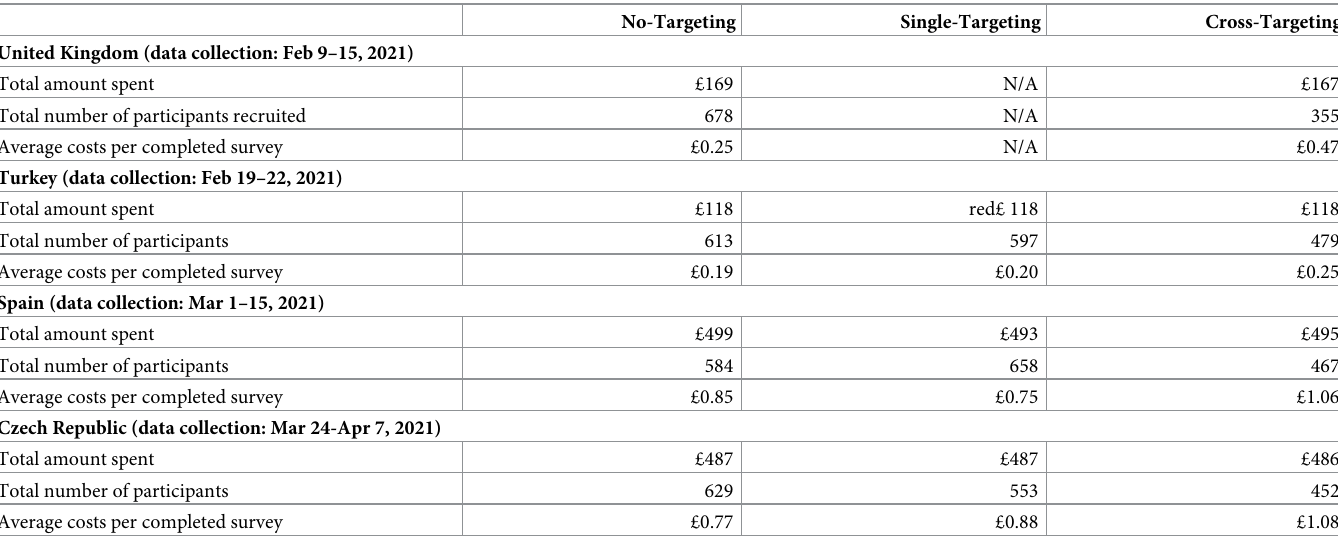
Table 5. Comparison of the cost of conversion-based targeting